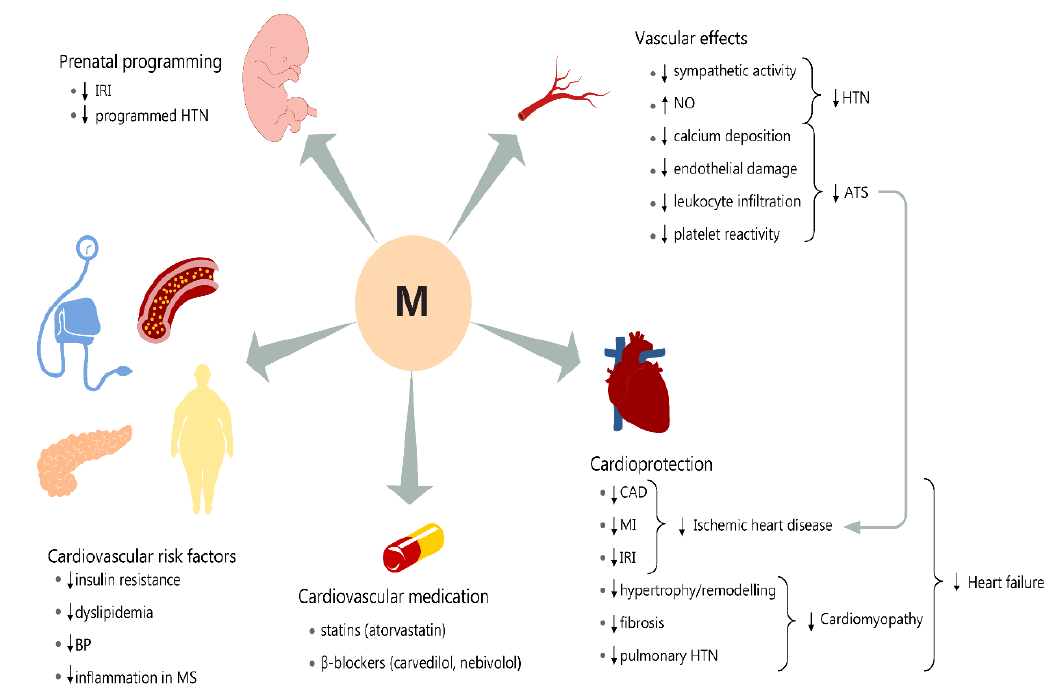
Figure 3. Cardiovascular effects of melatonin. ATS: atherosclerotic disease, BP: blood pressure, CAD: coronary artery disease, IRI: ischemia/reperfusion injury, HTN: hypertension, MI: myocardial infarction, MS: metabolic syndrome, NO: nitric oxide.